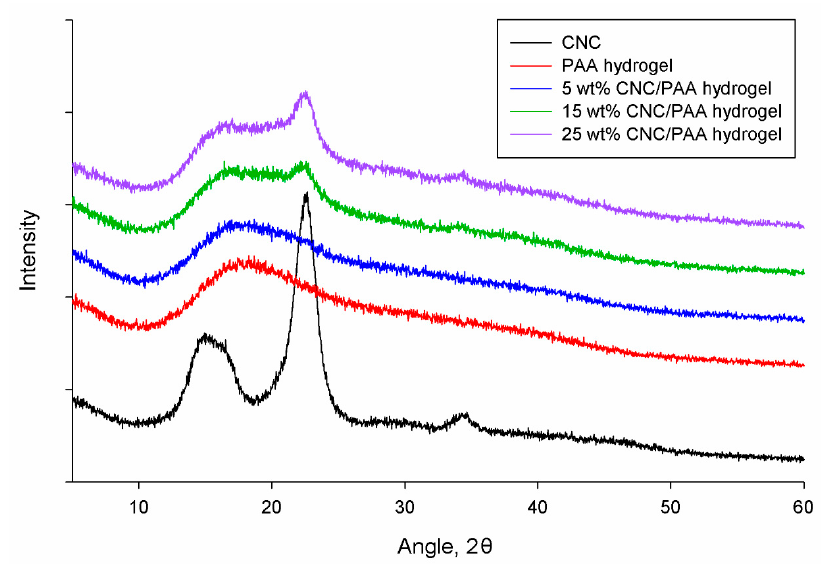
Figure 3. XRD diffractograms of CNC, PAA hydrogel, 5 wt % CNC/PAA hydrogel, 15 wt % CNC/PAA hydrogel, and 25 wt % CNC/PAA hydrogel.